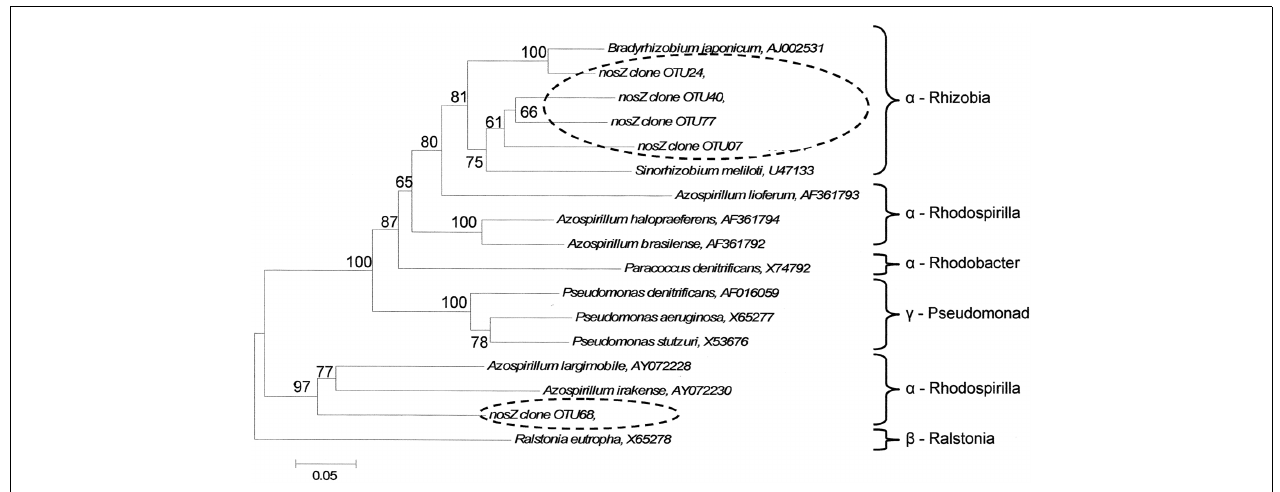
FIGURE 7 | Phylogenetic tree of cloned nosZ operational taxonomic units that significantly delineated land-use and time as determined by indicator species analysis. Broken ovals highlight cloned sequences from this study.The label of the sequence used in the analysis is followed by their respective GenBank accession. Branch nodes with bootstrap values greater than 60 are labeled. Scale bar indicates 5 changes per 100 nucleotide positions.